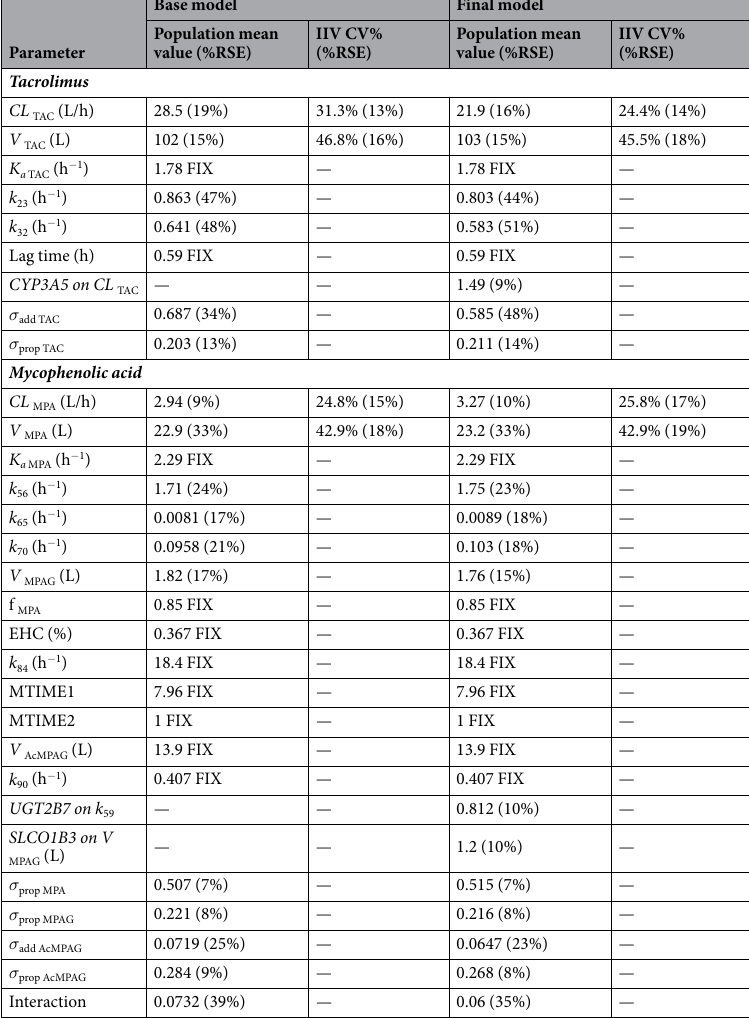
— — Table 2. Population pharmacokinetic parameter estimates of models for TAC and MMF. IIV, interindividual variability; CV, coefficient of variation; RSE, relative standard error; F, fraction of the dose absorbed; CL, clearance; TAC, tacrolimus; V, volume of distribution; K a , first-order absorption rate constant; k 23 , k 32 , k 56 , and k 65 , intercompartment rate constants; MPA, mycophenolic acid; k 70 and k 90 , eliminated rate constants; CYP3A5 , CYP3A5 expressers ( CYP3A5 * 1/ * 1 or CYP3A5 * 1/ * 3 carriers); f MPA , fraction of MPA which metabolized to MPAG; EHC, enterohepatic circulation; k 84 , gallbladder emptying rate constant; MTIME1, meal time; MTIME2, Gallbladder emptying duration; MPAG, MPA 7-O-glucuronide; AcMPAG, MPA acyl glucuronide; SLCO1B3 , SLCO1B3 rs4149117 T carrier; UGT2B7 , UGT2B7 rs7439366 T carrier; σ prop , proportional residual error; σ add , additive residual